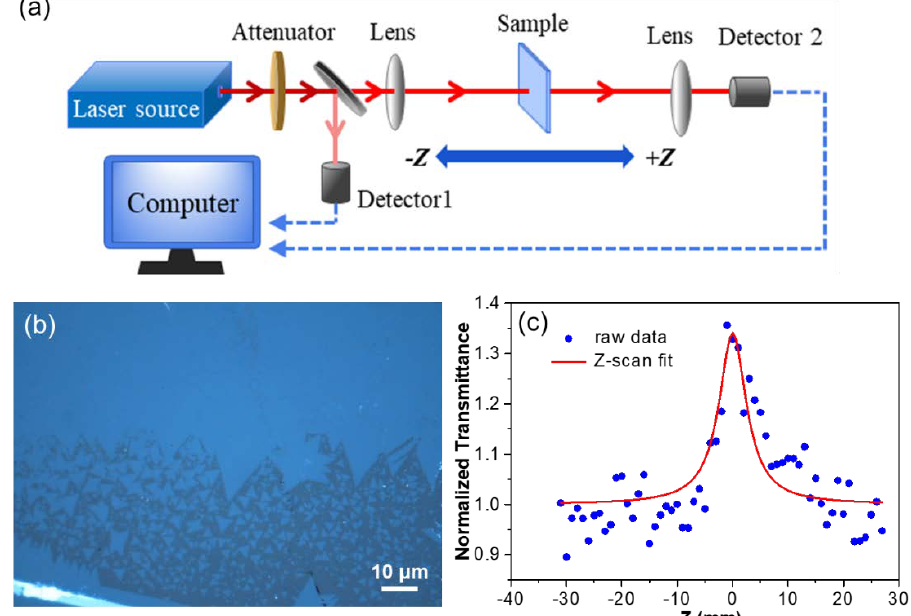
Figure 5. ( a ) The schematic diagram of the open-aperture Z-scan measurement system setup. ( b ) Optical image of monolayer MoSe 2 films grown on sapphire (0001) substrate. ( c ) Normalized transmittance and Z-scan fitting results.